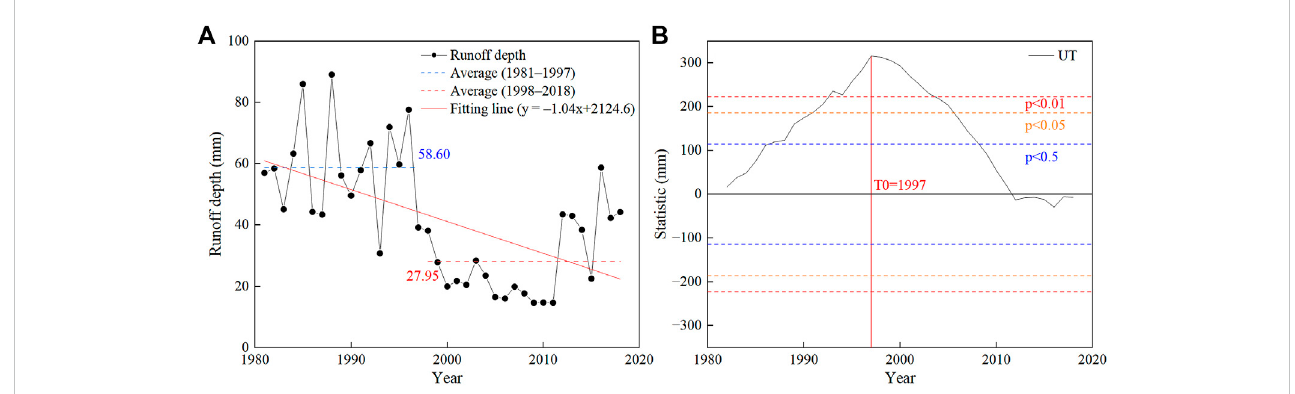
FIGURE 2 Runoff changes and Pettitt test statistics of runoff in the KRB (A) Runoff changes of KRB from 1981 to 2018 (B) Pettitt test statistics of runoff in the